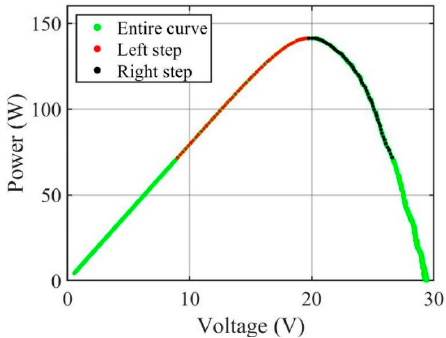
Figure 2. Measured P – U curve (green) jointly with cutting limits of 50% of P MPP on the left (red) and on the right (black) side of the MPP.